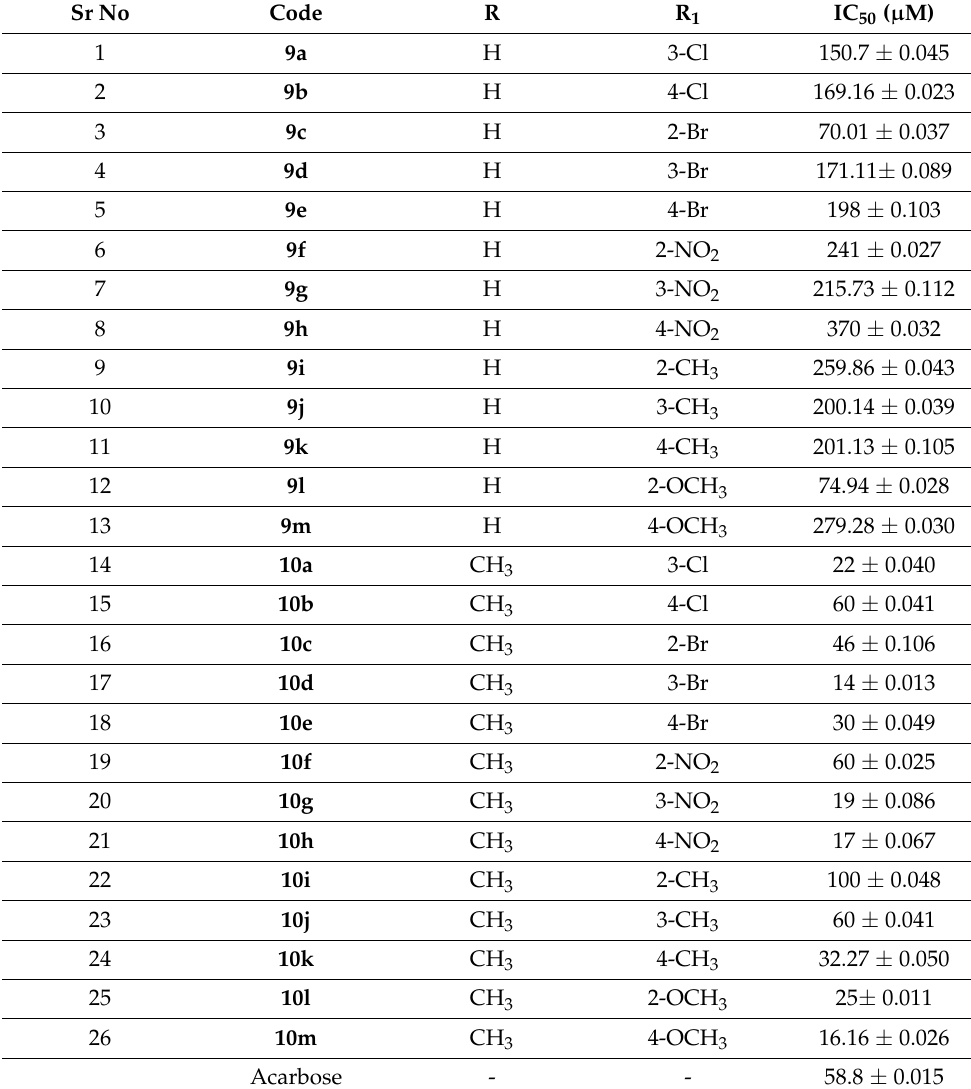
Table 2. In vitro α -glucosidase inhibitory (IC 50 ) activities of synthesized benzimidazolium